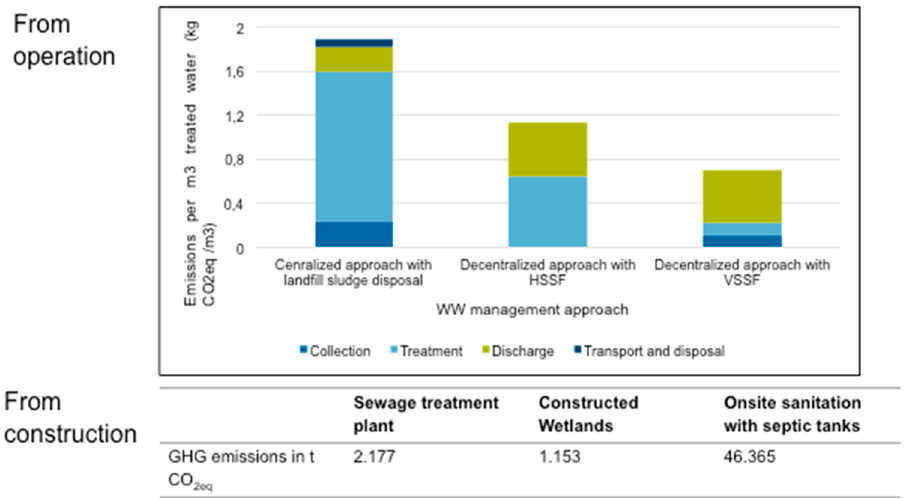
Figure 3. GHG emissions per m 3 of treated water in the 3 scenarios.